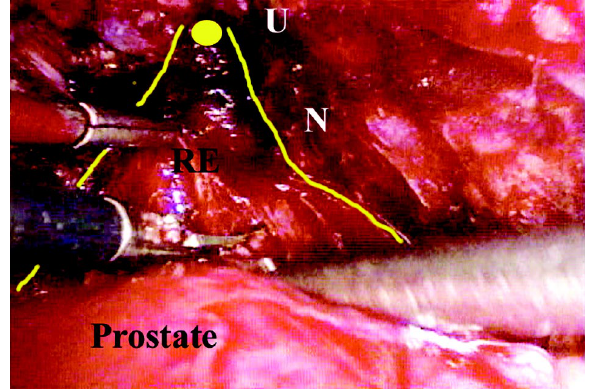
Figure 7 – Dissection of retroprostatic space. U = urethra (yel- low circle), RE = retroprostatic space, N = projection of nervi erigentes (yellow